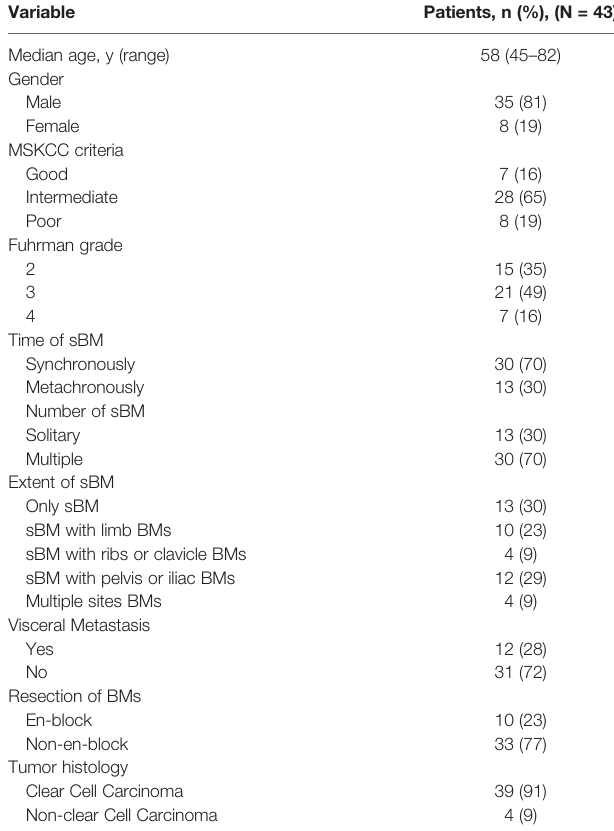
TABLE 1 | Clinical characteristics of newly diagnosed RCC with spinal